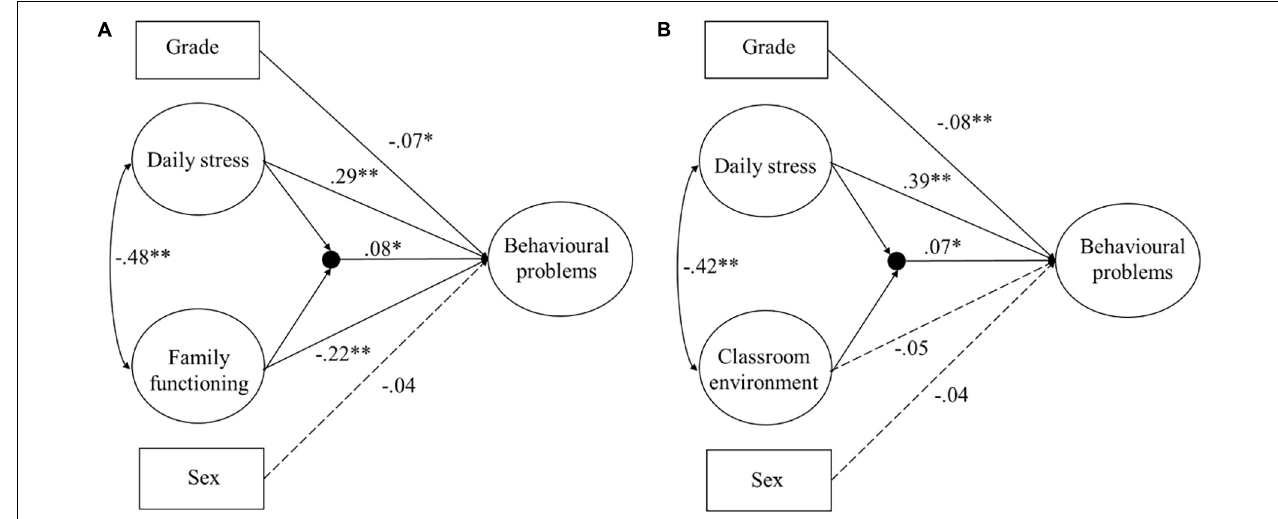
FIGURE 2 | Structural models with the latent variable interaction. (A) Model 1: Model including the latent variable daily stress × family functioning interaction, depicted as a filled circle according to Mplus standard notation; (B) Model 1: Model including the latent variable daily stress × classroom environment interaction. * p < 0.05, ** p <